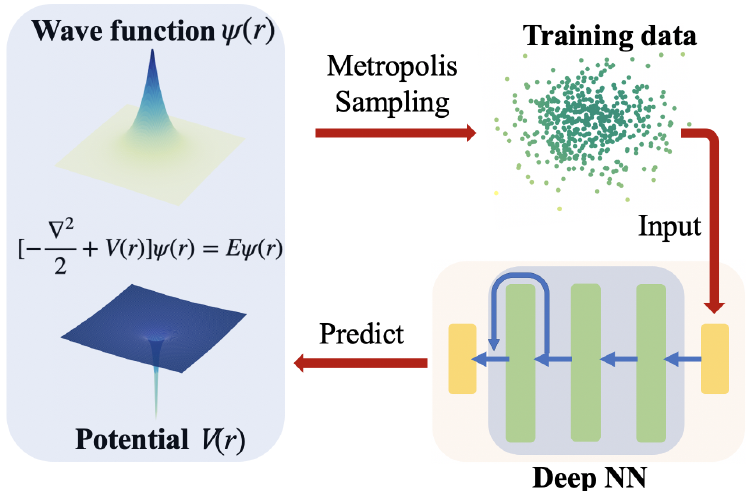
Figure 1: (Color online) The illustration of the main procedures of MPNN. With the potential U θ ( r ) predicted by the neural network, the target wave-function Ψ ( r ) is expected to be the eigenstate of the Hamiltonian ˆ H = −